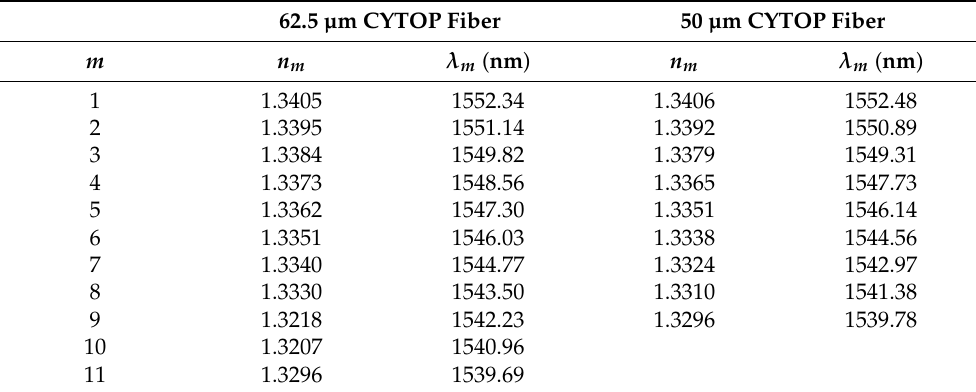
Table 3. The distribution of Bragg resonance wavelengths in 62.5µm and 50µm CYTOP fibers.